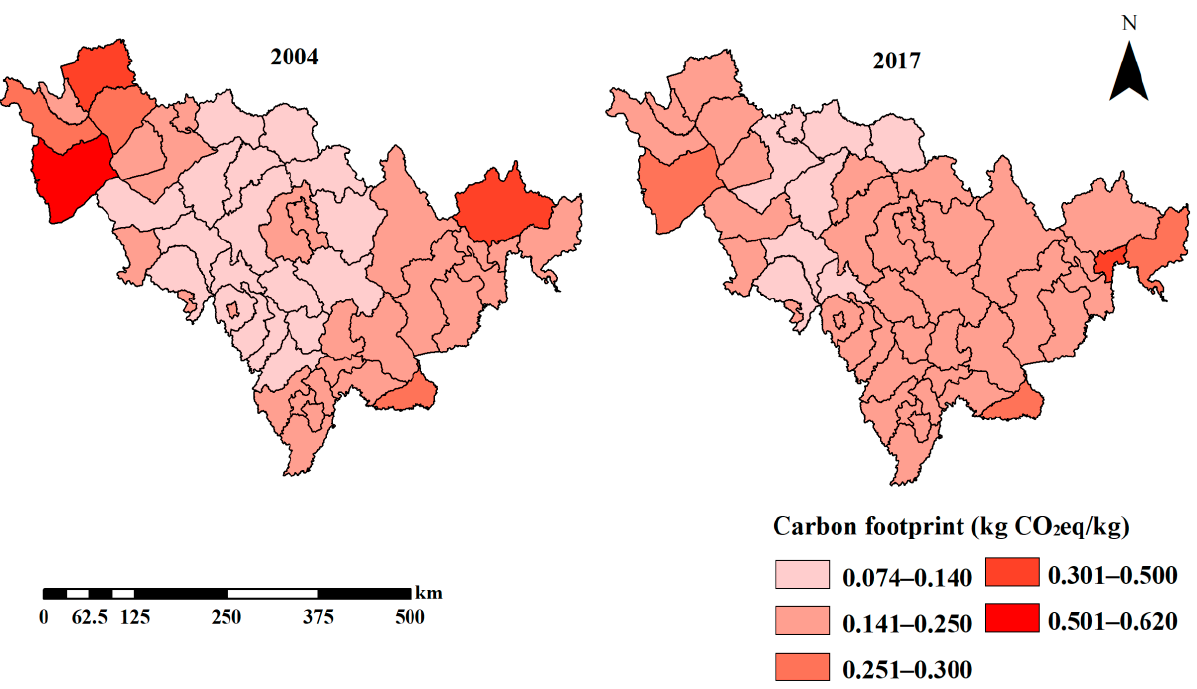
Figure 4. Spatial distributions of the CFs of maize production in 2004 and 2017. The constitutions of the CF of maize production were different among the regions in 2004 and 2017 (Figure 5). In 2004, the CF from N 2 O emissions was the highest in each region, especially in the western region, and the largest N 2 O emission was 0.076 kg CO 2 eq/kg. The CF caused by compound fertilizer production ranked second in its contribution to the overall CF of maize production. The CF due to diesel use was also high, and pesticide and seed production caused lower CFs. In 2017, compound fertilizer production became the largest emission source; CF caused by compound fertilizer production was 0.072 kg CO 2 eq/kg, followed by diesel combustion. Compared with 2004, the constitutions of the CFs changed greatly in 2017; the N 2 O emissions decreased obviously, while the carbon emissions caused by compound fertilizer production and diesel combustion increased greatly. This discrepancy is mainly due to the agricultural machine and compound fertilizer inputs increasing greatly in Jilin Province, especially in the middle east region of Jilin Province, which resulted in the CFs increasing significantly in the middle east region of Jilin Province in